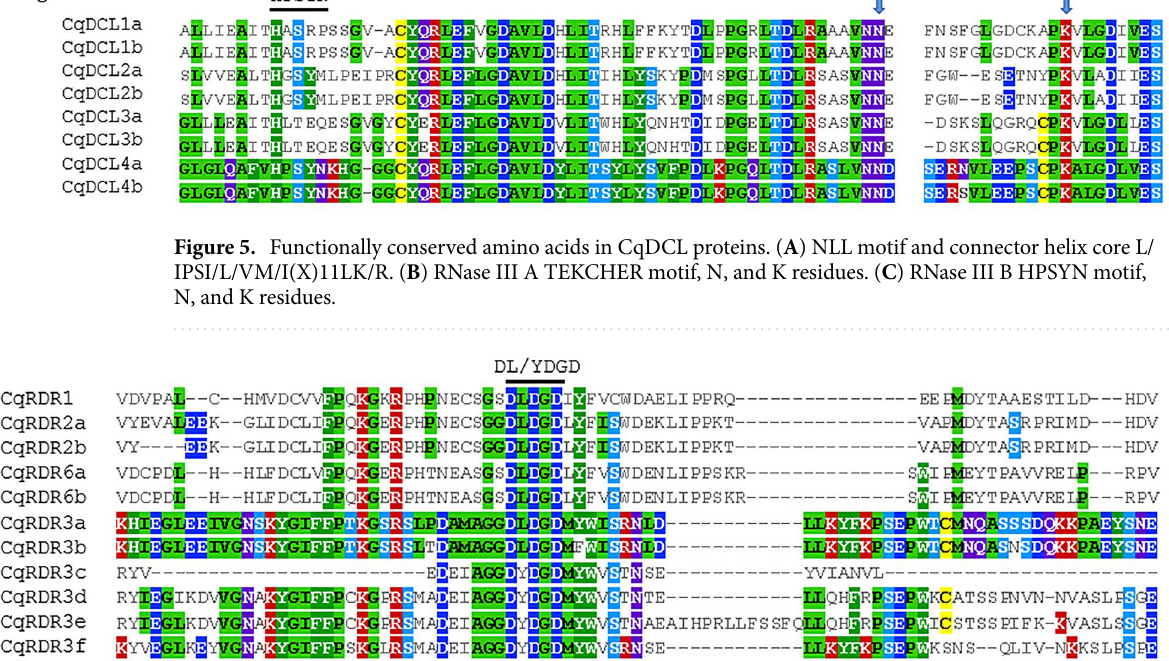
Figure 6. Functionally conserved DL/YDGD motif in CqRDR